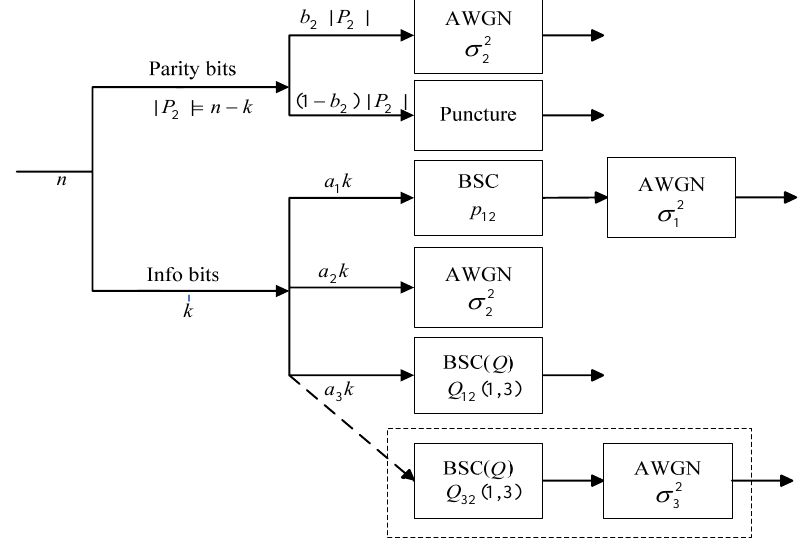
Figure 7. The parallel channel model of the source X box shows an alternative situation that we take X combined channel BSC ( Q ).